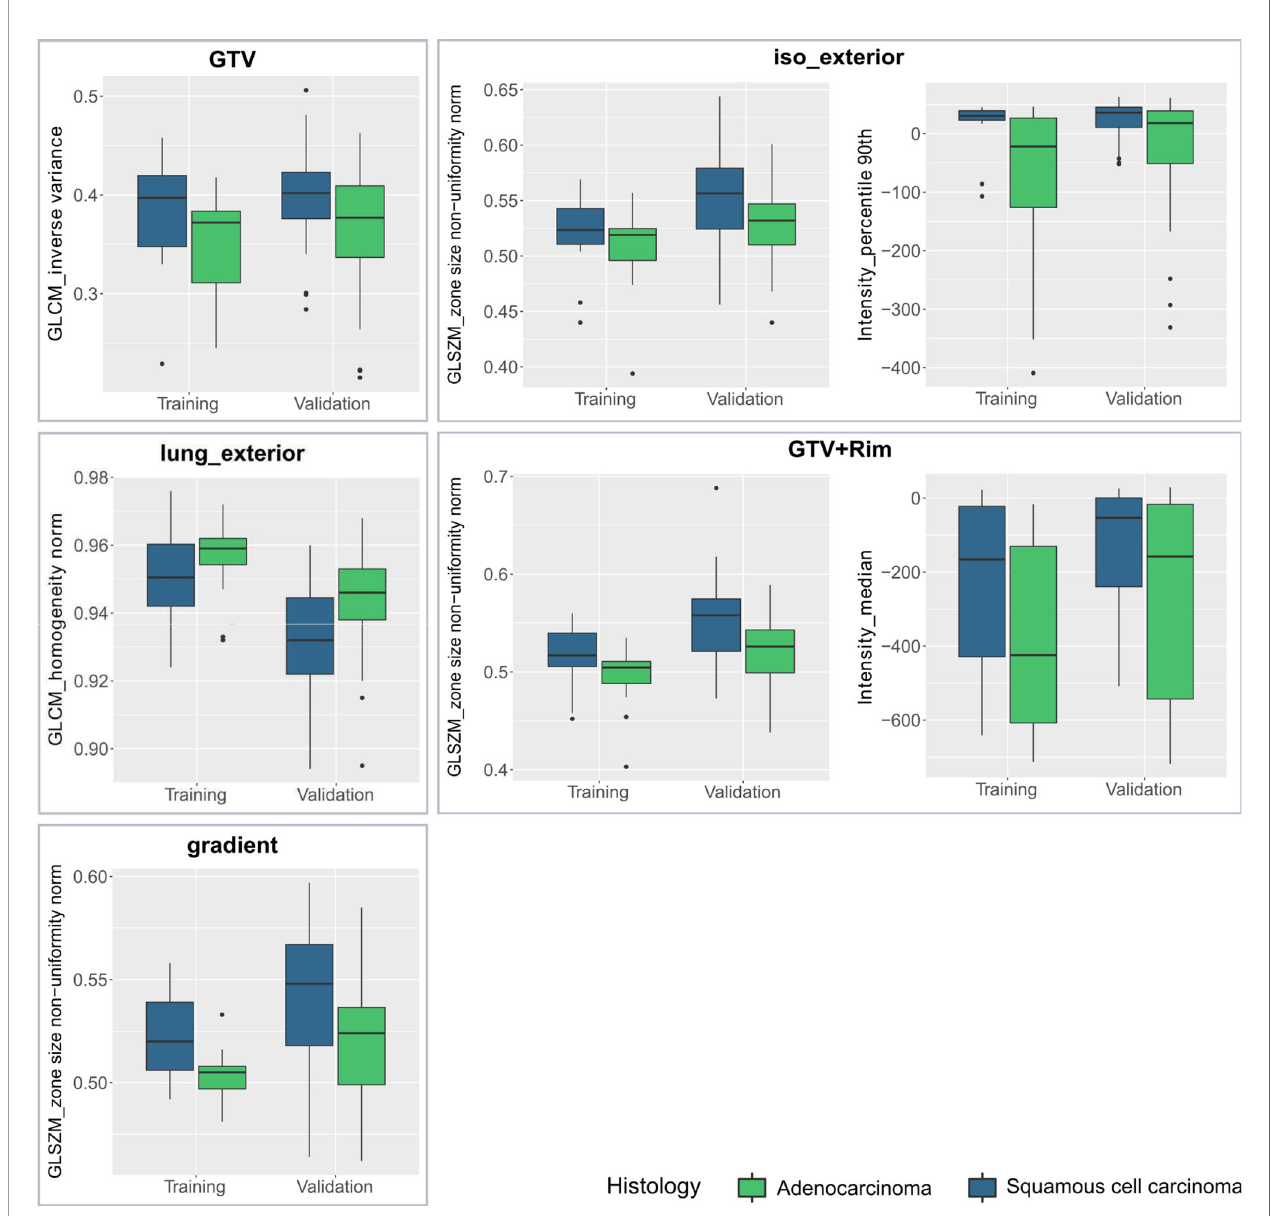
FIGURE 4 | Boxplots of each studied region of interest (ROI) strati fi ed by histological subtype (adenocarcinoma, squamous cell carcinoma) and dataset (training, validation) for the fi nal model